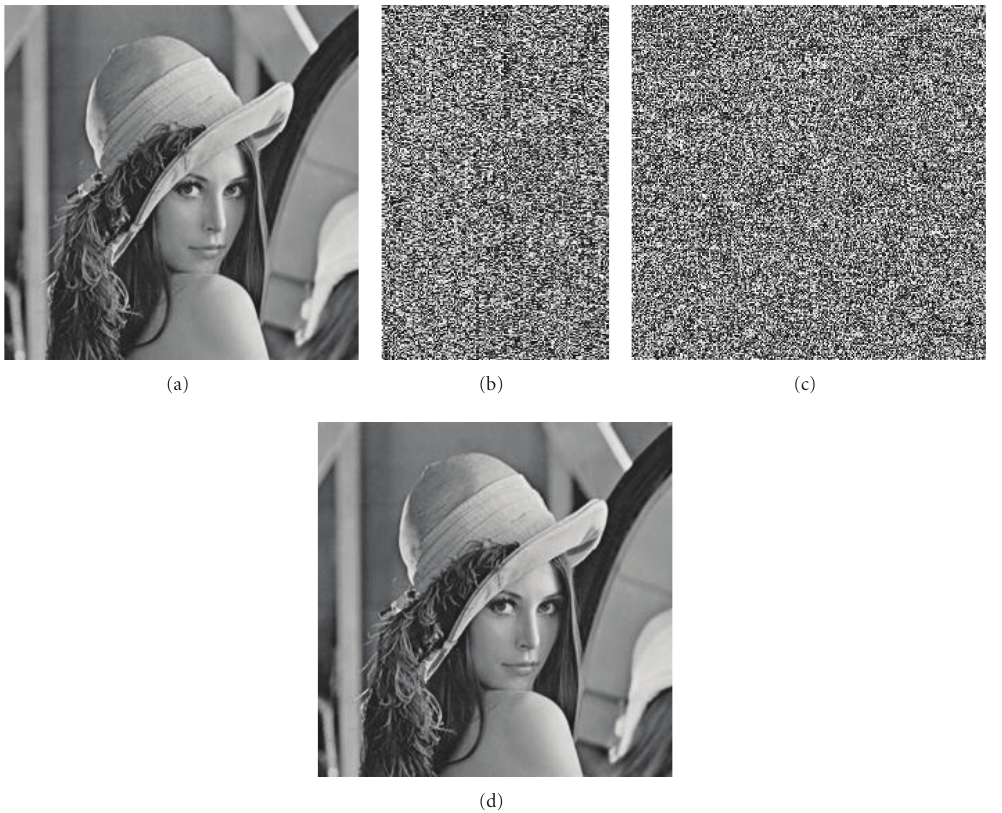
Figure 3: Encrypted image and decrypted image. (a) The original image. (b) The encrypted image. (c) The decrypted image under the wrong secret keys. (d) The decrypted image under the correct secret